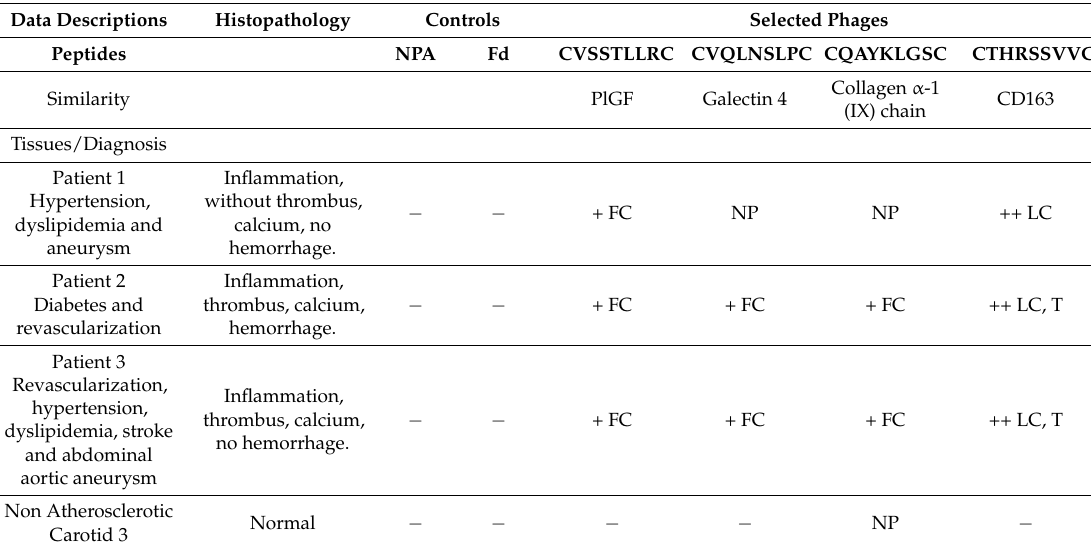
Table 1. Phage overlay in atherosclerotic and normal carotid